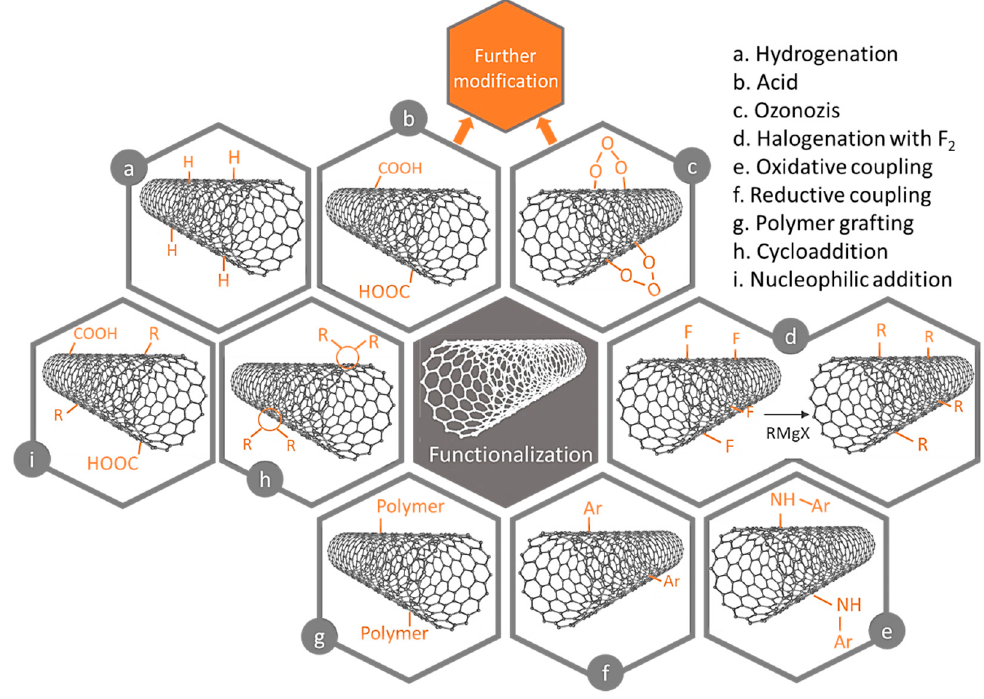
Figure 10. Overview of surface functionalization methods of over carbon nanotubes (CNTs).